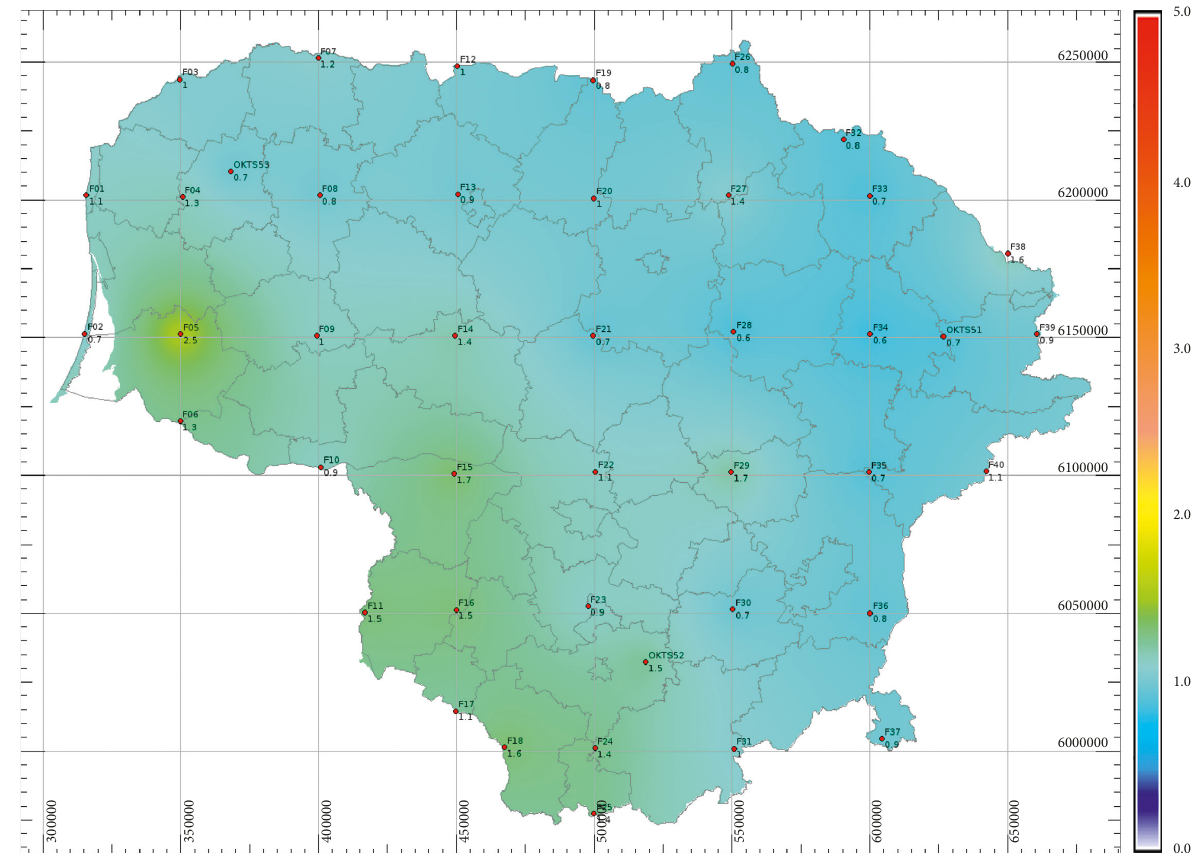
Figure 8: Annual mean concentrations of SO 2 in the zone (58 cities) for the period from 3 November 2010 to 4 July 2011. 0.00.51.01.52.02.53.03.54.0